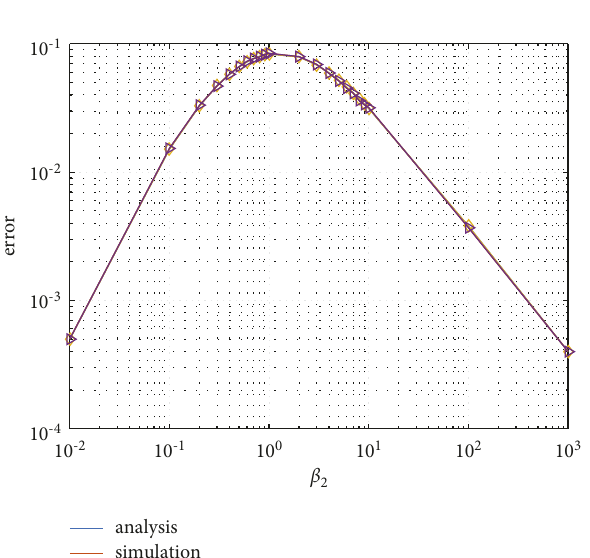
Figure 5: Statistical error versus β